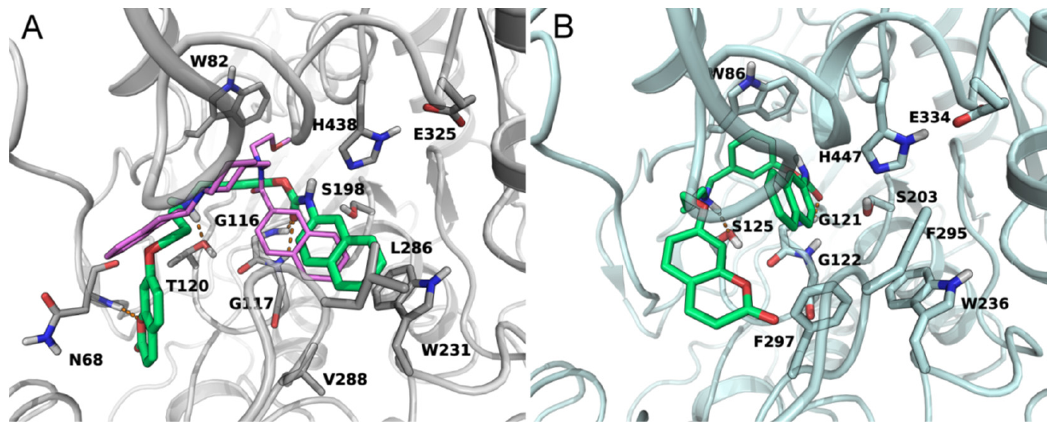
Figure 3. ( A ) Docking of compound 4 (green carbons) in the substrate binding site of h BuChE (grey ribbons). The coumarin head points towards the entrance of the gorge undertaking polar contacts with the backbone of N68. The N -naphthyl group fits the acyl chain binding pocket, overlapping the position of the naphthamide group of the inhibitor crystallized in the X-ray structure 4TPK (purple carbons). ( B ) Docking of compound 4 (green carbons) in the substrate binding site of h AChE (cyan ribbons). Given the presence of the bulkier F295 and F297, the N -naphthyl group cannot occupy the acyl chain binding pocket. Hydrogen bonds are indicated with orange dotted lines.